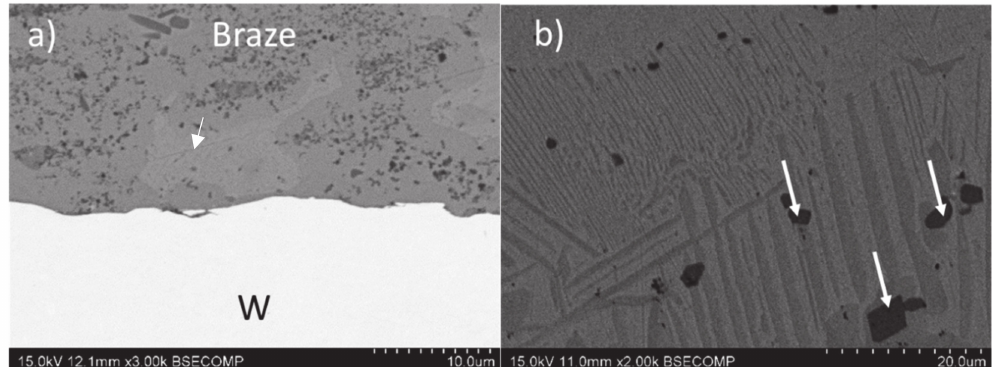
Figure 4. SEM micrograph of the W-CuCrZr brazed joint at: ( a ) W-braze interface and ( b ) braze zone.